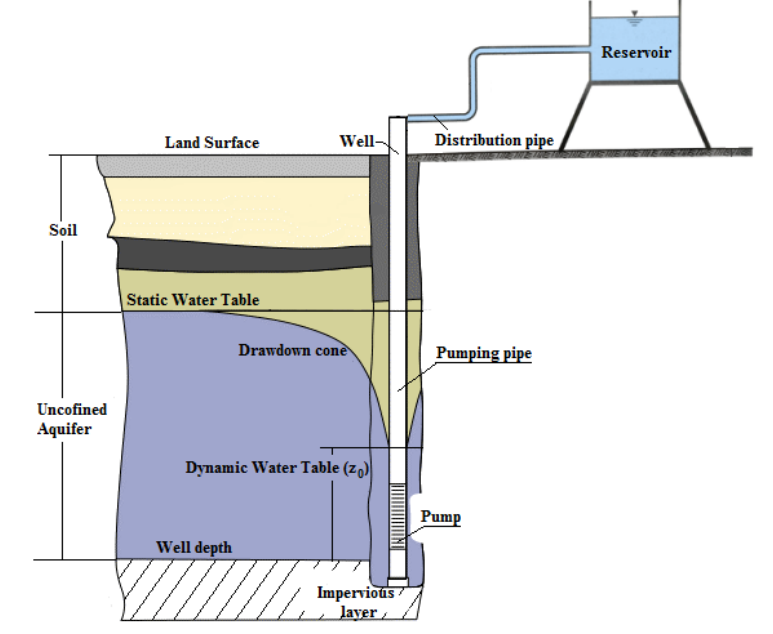
Figure 1. Infrastructure of the analyzed system.